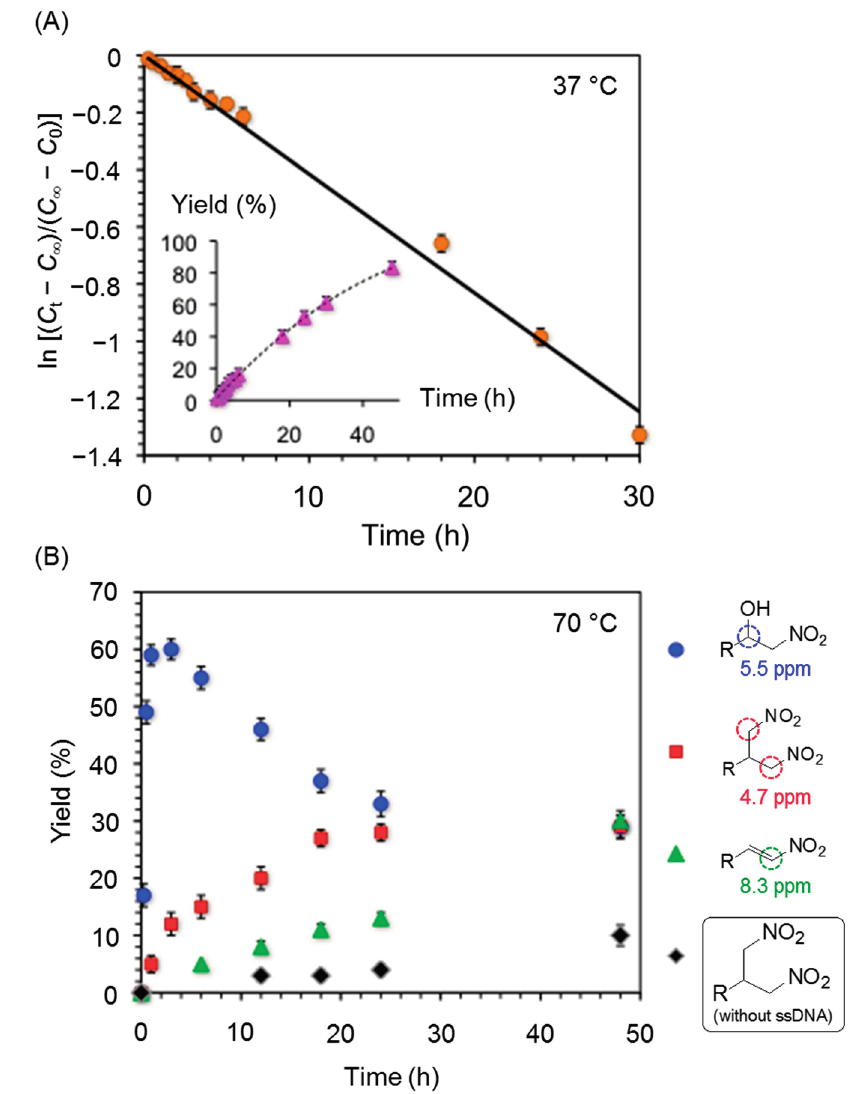
Figure 2. ( A ) First-order kinetics plot of the model nitroaldol reaction between 1a and 2a catalyzed by ssDNA as described in Table 3. C ∞ = final concentration, at infinite time; C t = concentration at given time t; C 0 = initial concentration, at t = zero time. R 2 = 0.99. Inset: Evolution of reaction conversion over time; ( B ) Formation of β -nitroalcohol 3a , nitroalkene and 1,3-dinitro derivatives from the reaction between 1a (0.1 mmol) and 2a (1.0 mmol) catalyzed by ssDNA (2 mg) at 70 °C. Kinetics profile of the 1,3-dinitro compound in the absence of ssDNA is also